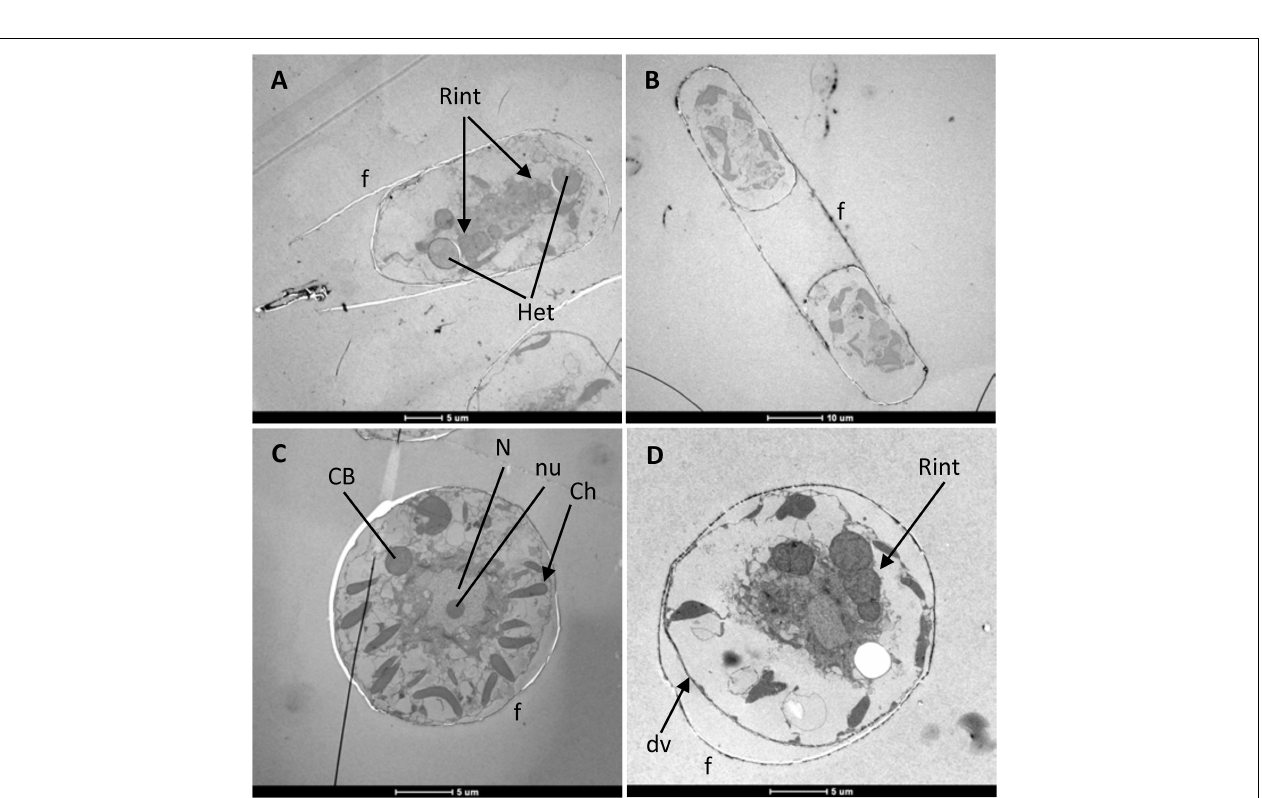
Frontiers in Microbiology |